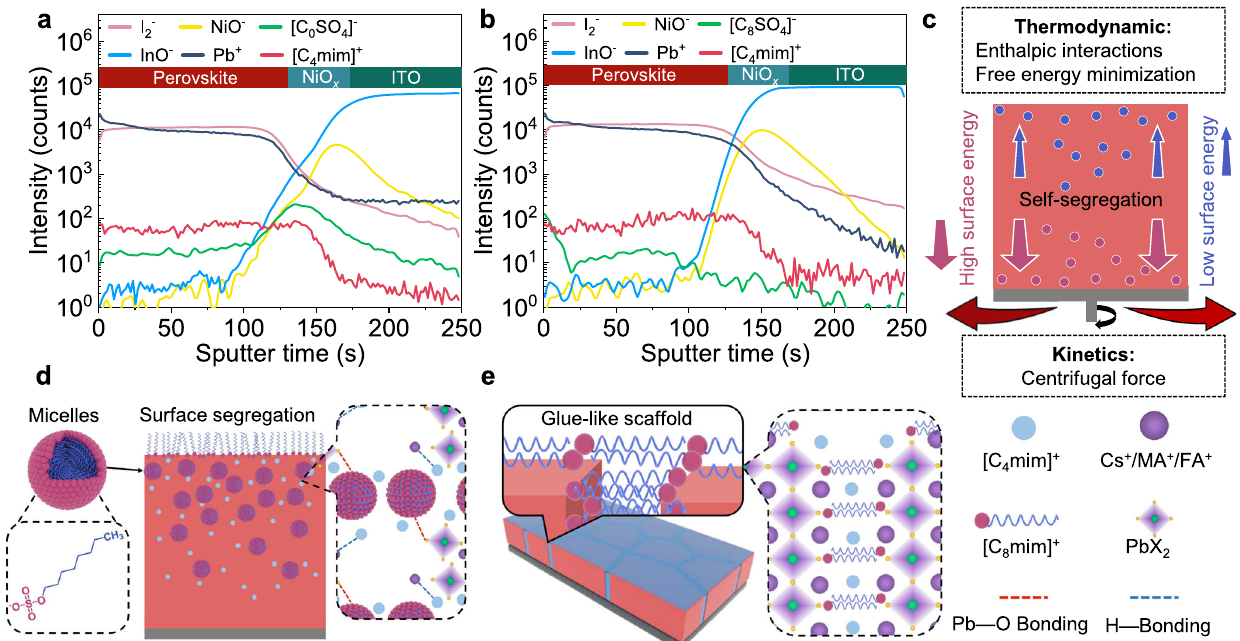
Fig.2|SegregationandmicellizationofLASs.a , b ToF-SIMSdepthpro fi lesofthe [C 4 mim] + [C 0 SO 4 ] − ( a ) and [C 4 mim] + [C 8 SO 4 ] − ( b ) treated perovskite fi lms. Both samples display the uniform Pb + and I 2 − distributions throughout the entire per- ovskite bulk, in good agreement with the component distributions acquired from the control sample without additive (Supplementary Fig. 7). The existence of NiO − and InO − ions can be associated with the spatial distribution of NiO x , ITO,